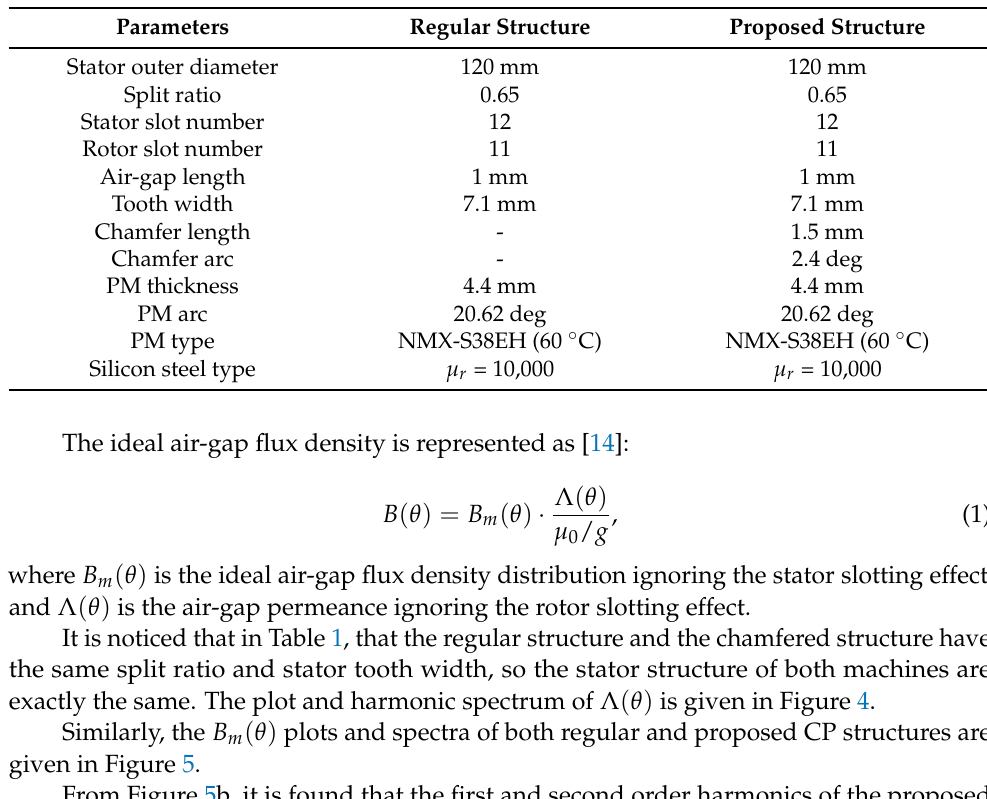
Figure 3. Flux line distribution. ( a ) Regular CP structure; ( b ) Chamfered CP structure. Table 1. Design parameters of both